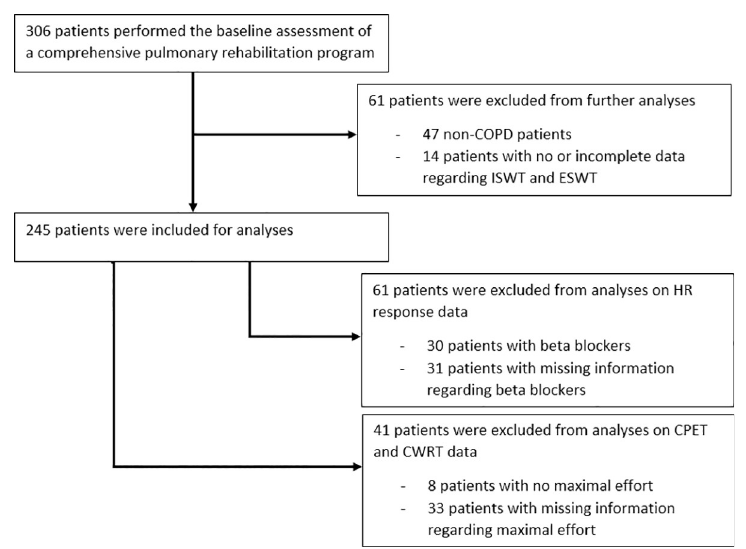
Fig 1. Flowchart of in- and exclusion of patients for analysis. Definitions of abbreviations: COPD = chronic obstructive pulmonary disease, CPET = cardiopulmonary exercise test, CWRT = constant work rate test, HR = heartrate, ISWT = incremental shuttle walk test, ESWT = endurance shuttle walk test.